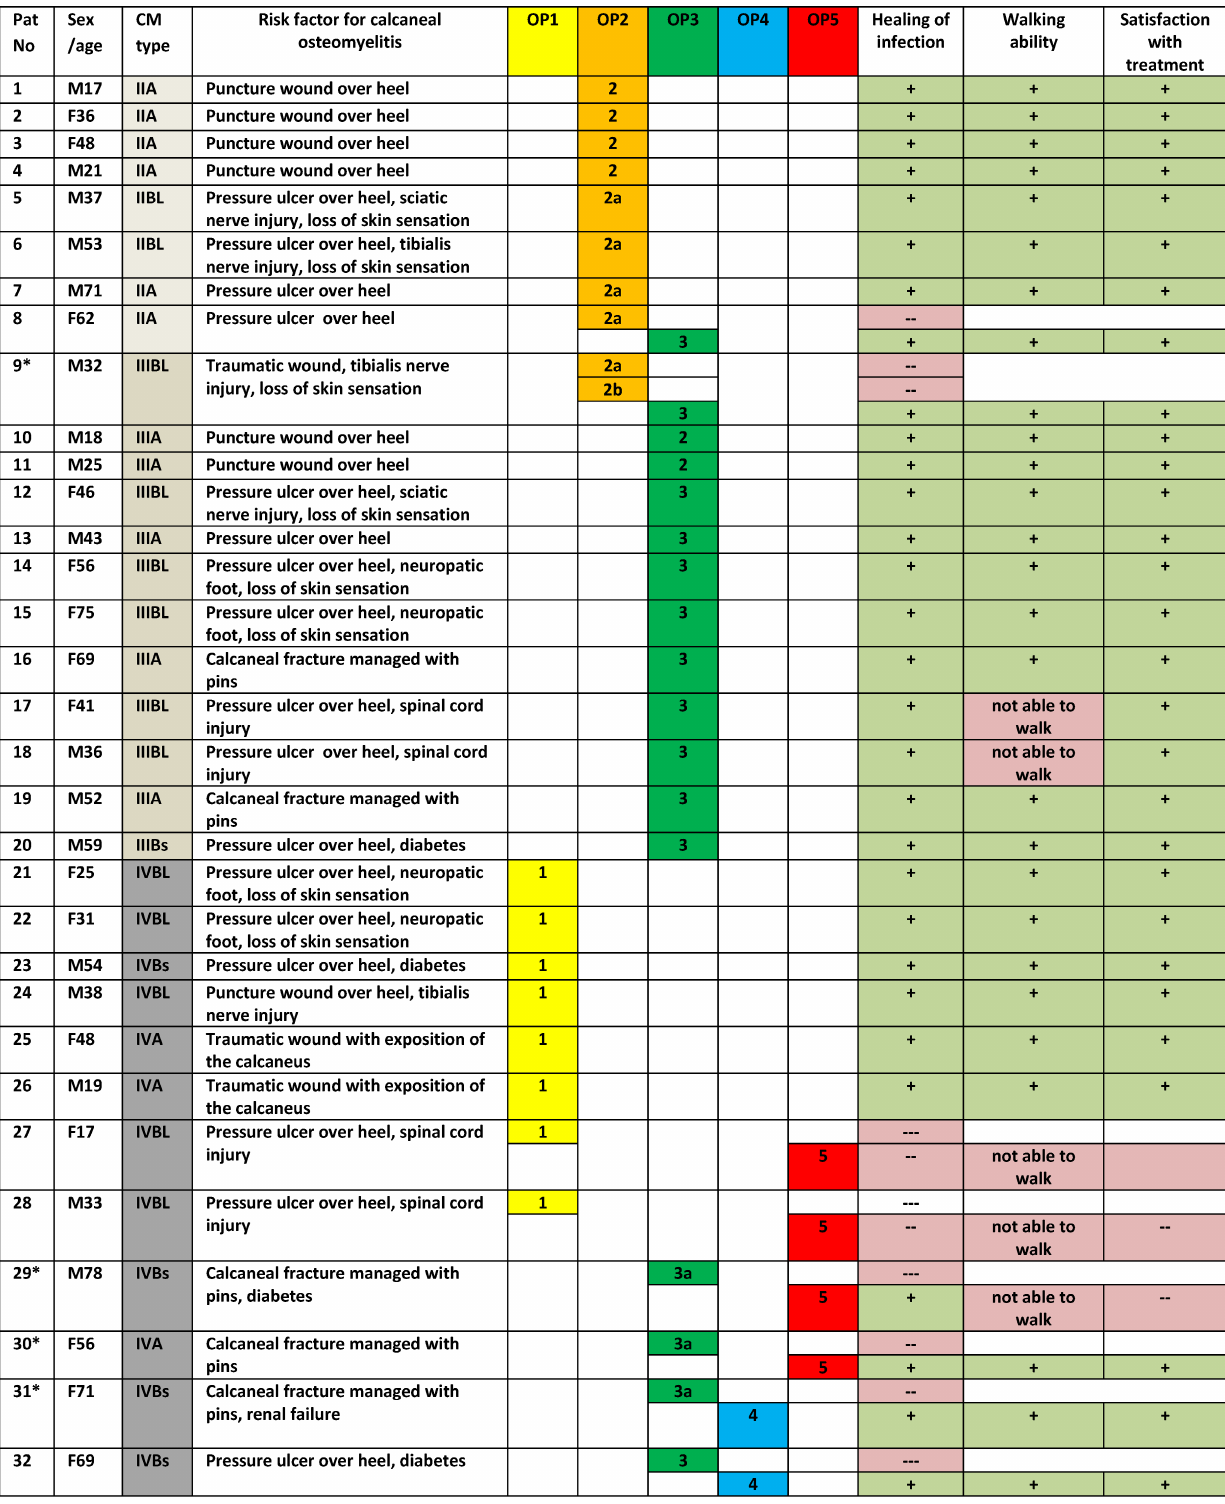
Table 1 . Characteristics of 32 patients and 41 operations performed for calcaneal osteomyelitis. Table legend: *staged or repetitive surgery; Operations: OP1- Drilling + Collagen Gentamicin Sponge; OP2 - Debridement; 2a - Debridement + fasciocutaneous flap; 2b - Debridement + cross-leg fascio-cutaneous flap; OP3 - Partial calcanectomy; 3a - Partial calcanectomy +Antibiotic Loaded Acrylic Cement Spacer; OP4 - Calcanectomy; OP5 - Below-the knee